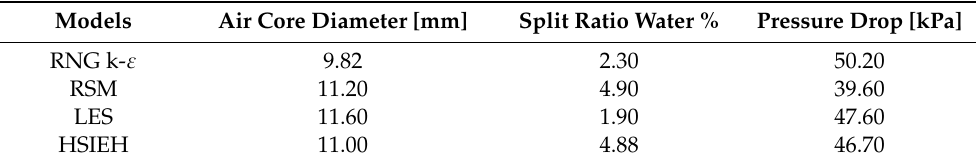
Table 4. Summarized results from turbulence models implementation.